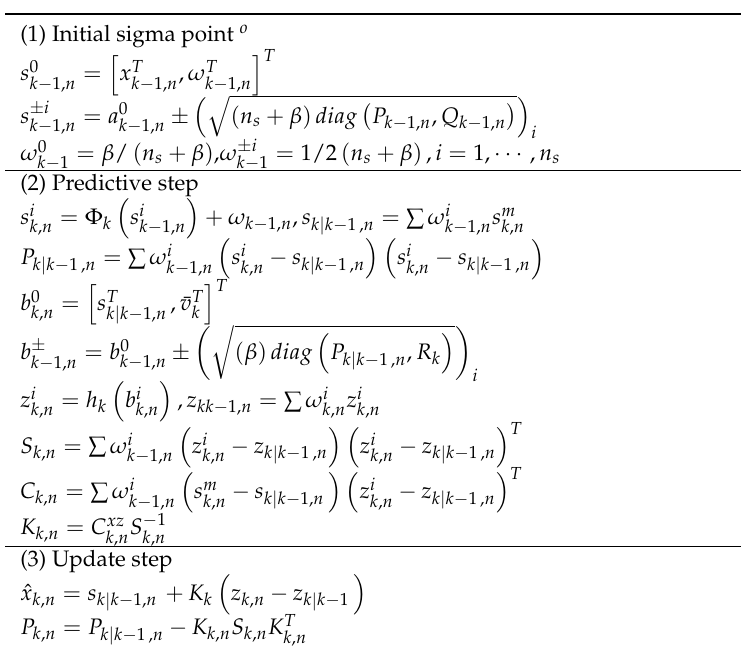
Table 2. UKF Algorithm Step